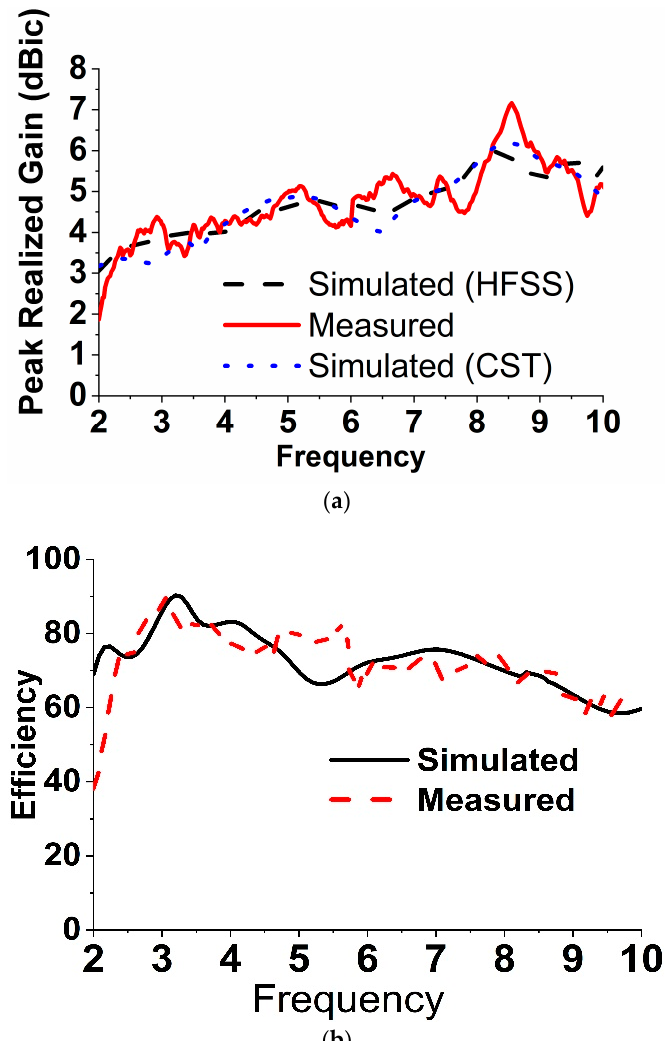
Figure 8. The numerical and measured ( a ) peak realized gain and ( b ) efficiency.